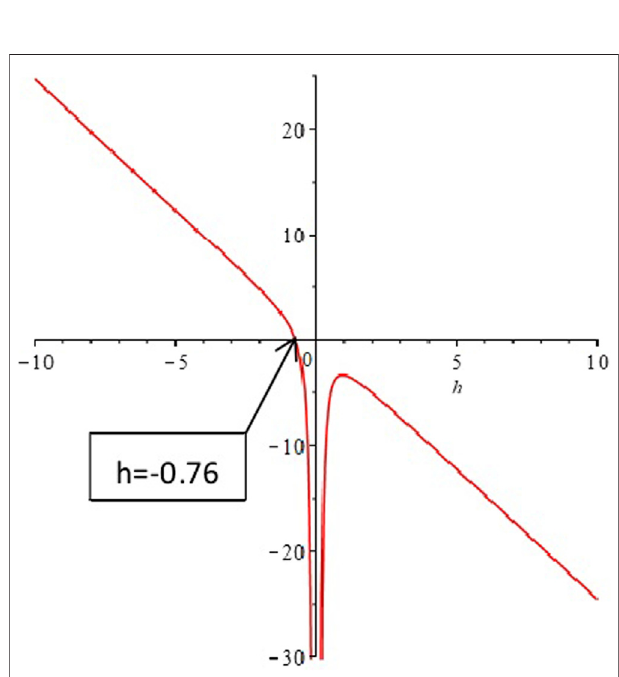
FIGURE 5 | The function image of the derivative of π 2 with respect to h